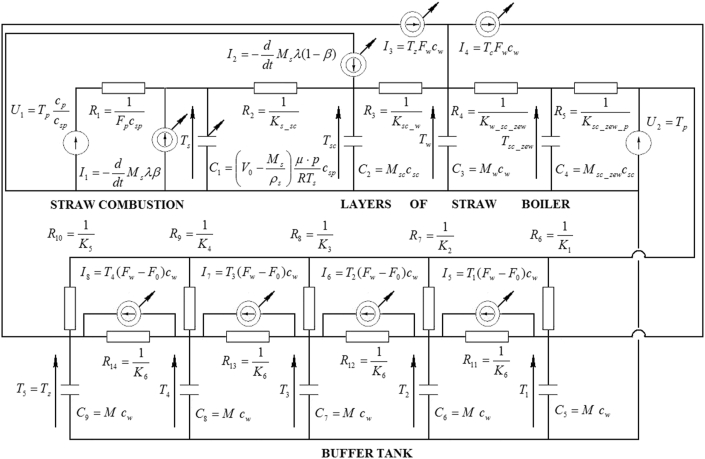
Diagram of the batch-fired straw boiler installation exhibited in the form of electrical network. Some elements of the circuit are time-variant (marked with a diagonal arrow).